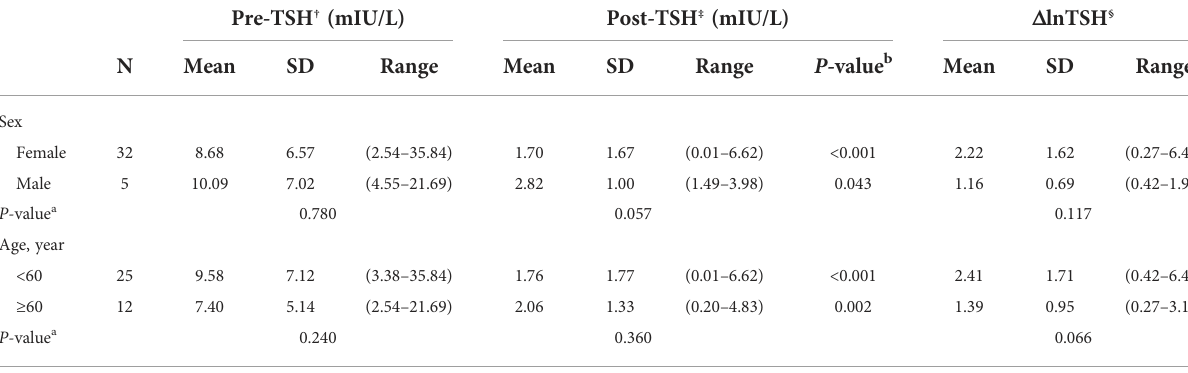
TABLE 3 Comparison of the pre- and post-TSH concentrations and D lnTSH of the different groups strati fi ed by sex and age.